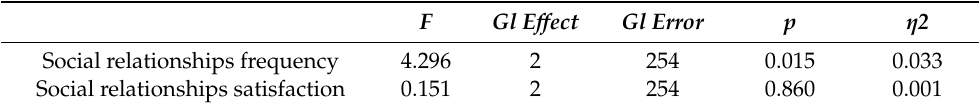
Table 3. ANOVAs testing continuation of social relationships depending on the level of activity. F Gl Effect Gl Error p η 2 Social relationships frequency 4.296 2 254 0.015 0.033 Social relationships satisfaction 0.151 254